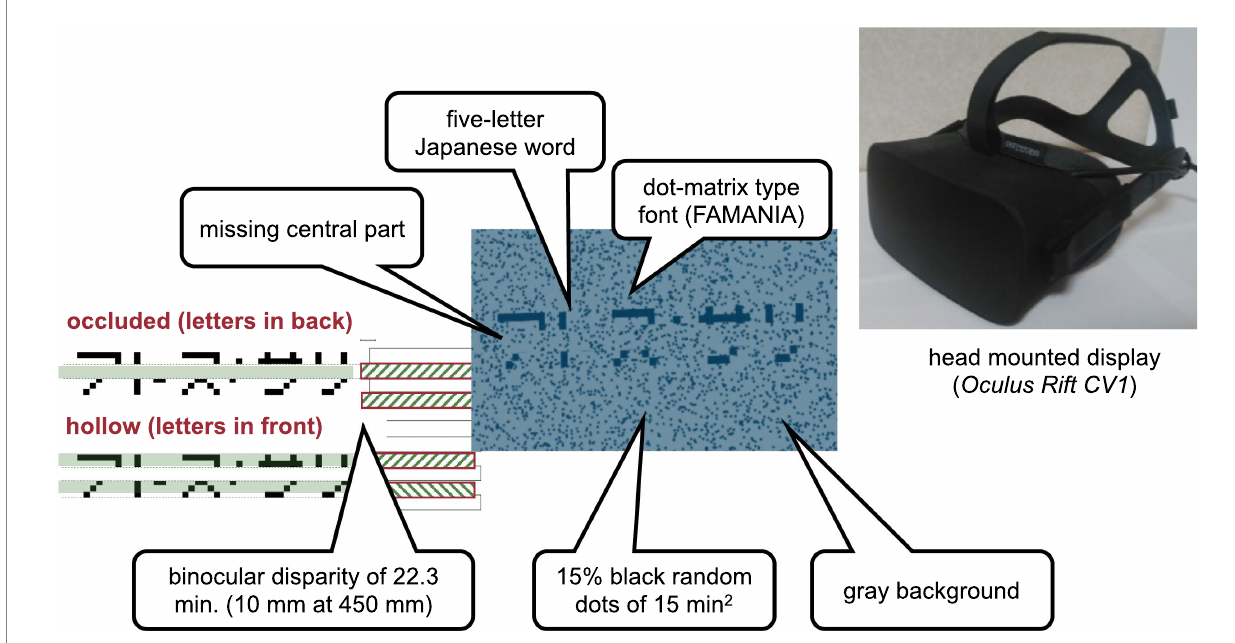
FIGURE 1 Visual stimulus. The haptic stimulus (Figure 2) was a wooden board. Four horizontal square-wave bumps were created on the board by gluing square columns in parallel onto the surface. Multiple bumps were made to change the physical position of the edge across trials to eliminate artifactual cues and interferences from a nonvarying stimulation. The edges of the square columns were aligned with the edges of the virtual ribbon in the VR space. The participants actively traced one of the edges of one of the columns using the tip of the index finger of their right hands to receive haptic input (Figure 3). An Oculus Touch controller was used for positional alignment between vision and haptics. The participants held the Oculus Touch controller while tracing the specified edge. The position of the fingertip was visually indicated by a blue virtual ball that moved in real-time synchrony with the motion of Oculus Touch in the head-mounted display. The VR system was implemented using Unity 2017.4.15f1. The latency was within 25 ms after the movement onset and then within 5 ms on average (Warburton et al., 2022). The participant sat on a chair and was confronted with a wooden board on a desk 45 cm in front of them. A chinrest was used to minimize head